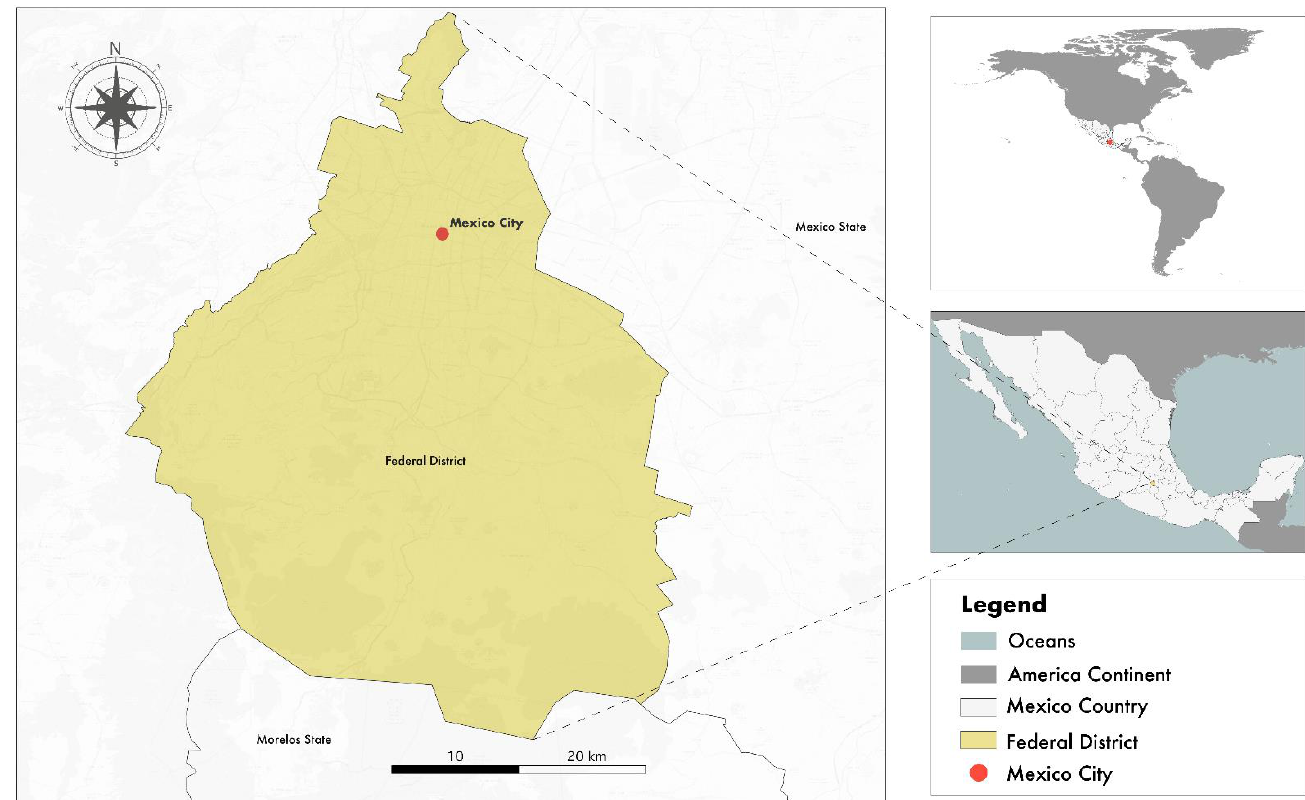
Figure 1. Location of Mexico City.